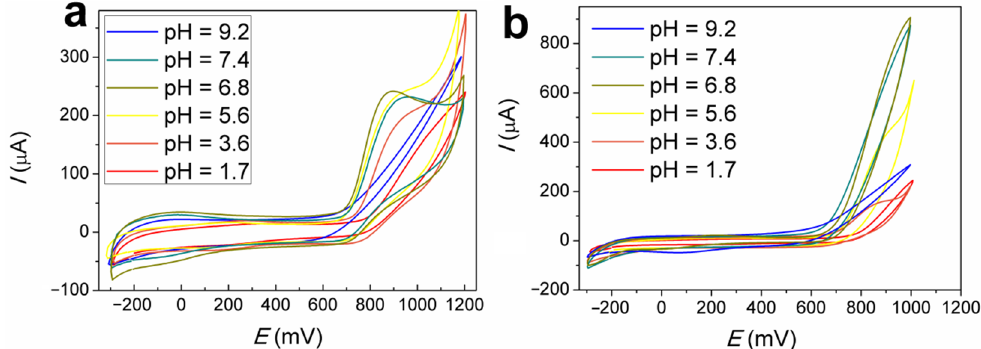
Figure 3. CVs curves of the FePc(tBu) 4 /GCE ( a ) and Au/FePc(tBu) 4 /GCE ( b ), recorded in electrolytes with various pH balances, containing 1.25 mM NaNO 2 , at a scanning rate of 100 mV/s. 3.4. Cyclic Voltammetry Characterization of GCE, FePc(tBu) 4 /GCE, and Au/FePc(tBu) 4 /GCE From the CV curves of the GCE (Figure 4a), FePc(tBu) 4 /GCE (Figure 4c), and Au/FePc(tBu) 4 /GCE (Figure 4e), at a recorded pH = 6.8, in the range of nitrite concentra- tions from 0.25 to 2.5 mM, the peaks associated with the oxidation of nitrate ions (anodic branch) were detected at 1020, 905, and 875 mV, respectively.